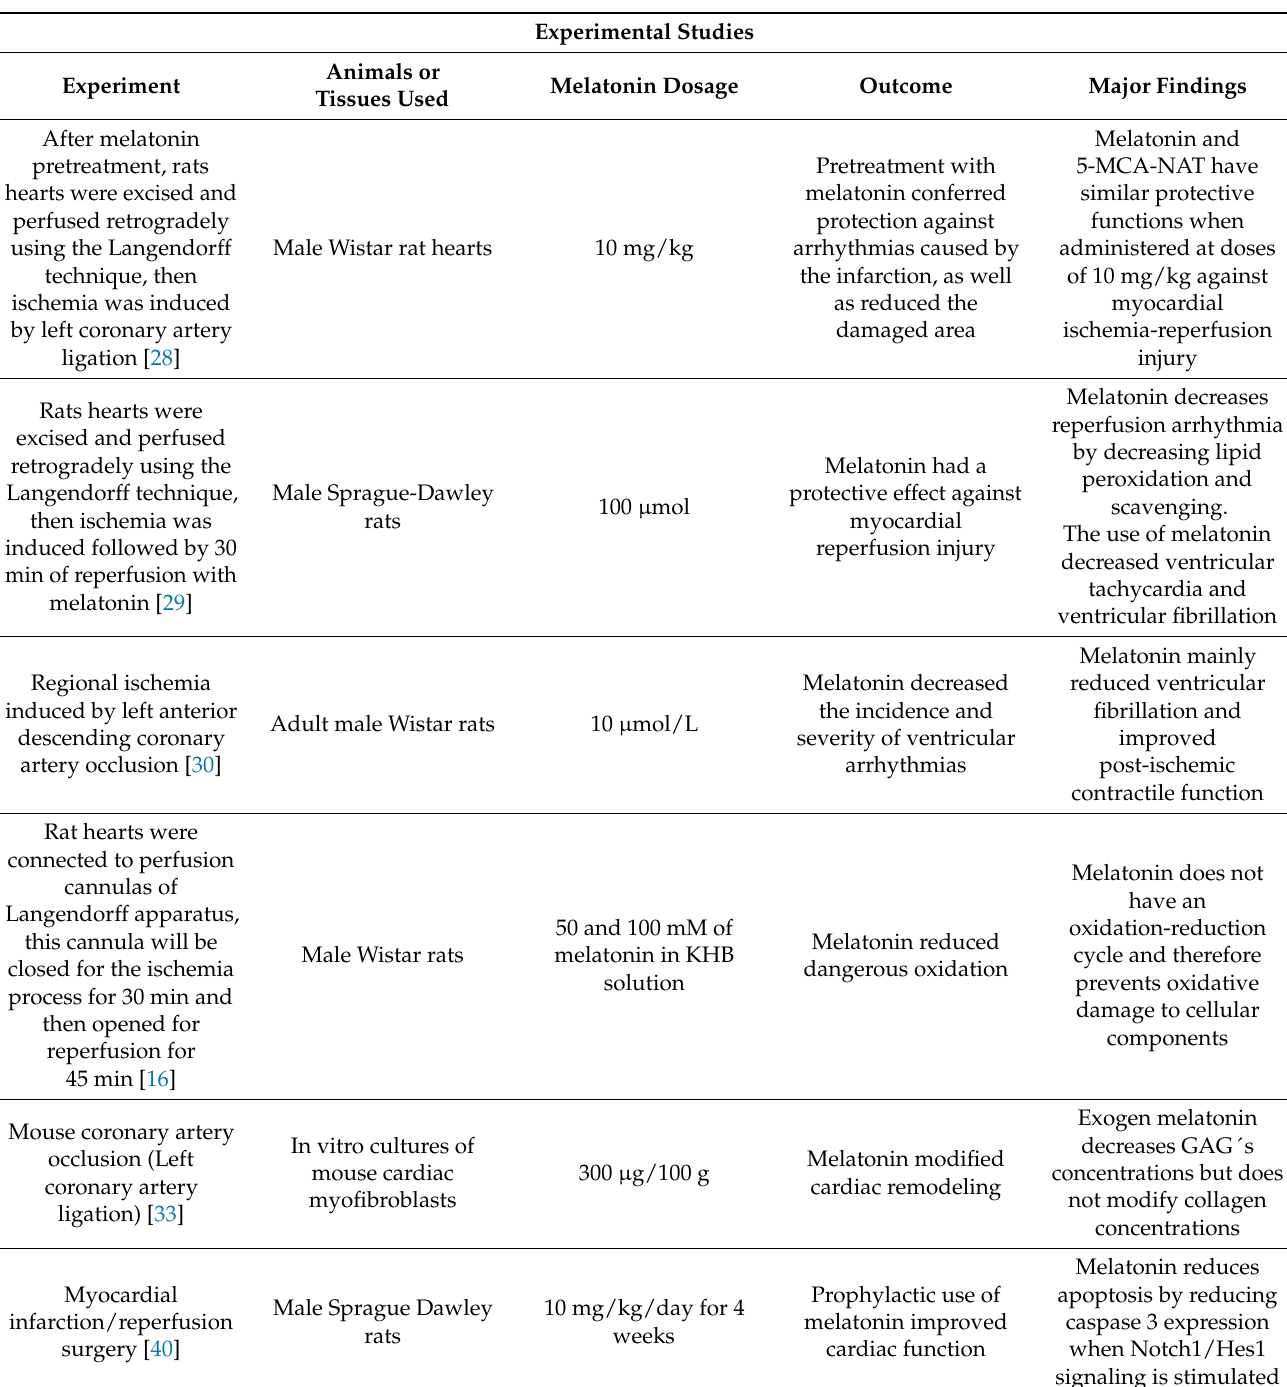
Table 1. Experimental studies that assessed melatonin’s efficacy for ischemia-reperfusion